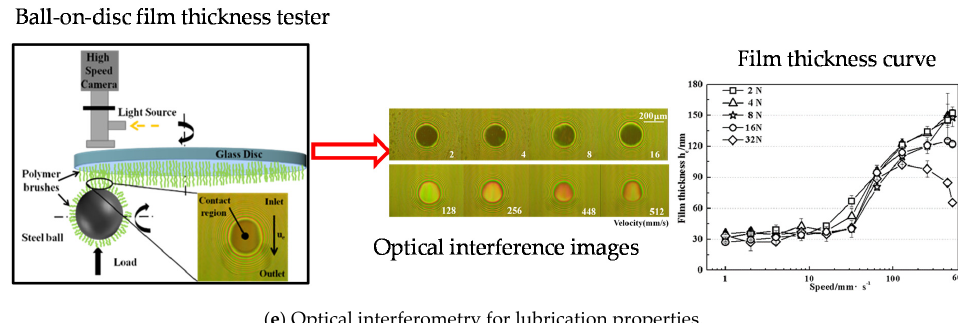
Figure 1. Schematic diagram of test methods and measuring devices: ( a – c ) are schematic diagrams of “grafting to” and “grafting from”; the "grafting to" polymer brush is fixed to the substrate surface by chemical bonding, and the "grafting from" polymer brush is achieved by surface-initiated polymerization. ( d ) is the friction pair of the friction tester used to measure the friction and wear between the ball and plates grafted by polymer brush; and ( e ) is the film thickness measurement device to obtain the optical interference image and the film thickness curve for studying the film-forming property induced by polymer brush.